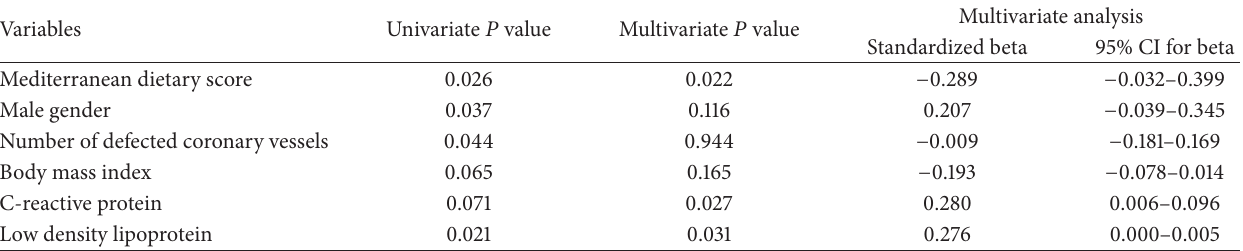
Table 4: Multivariate analysis for determining the effects of Mediterranean dietary score on serum magnesium concentration adjusted for baseline variables as